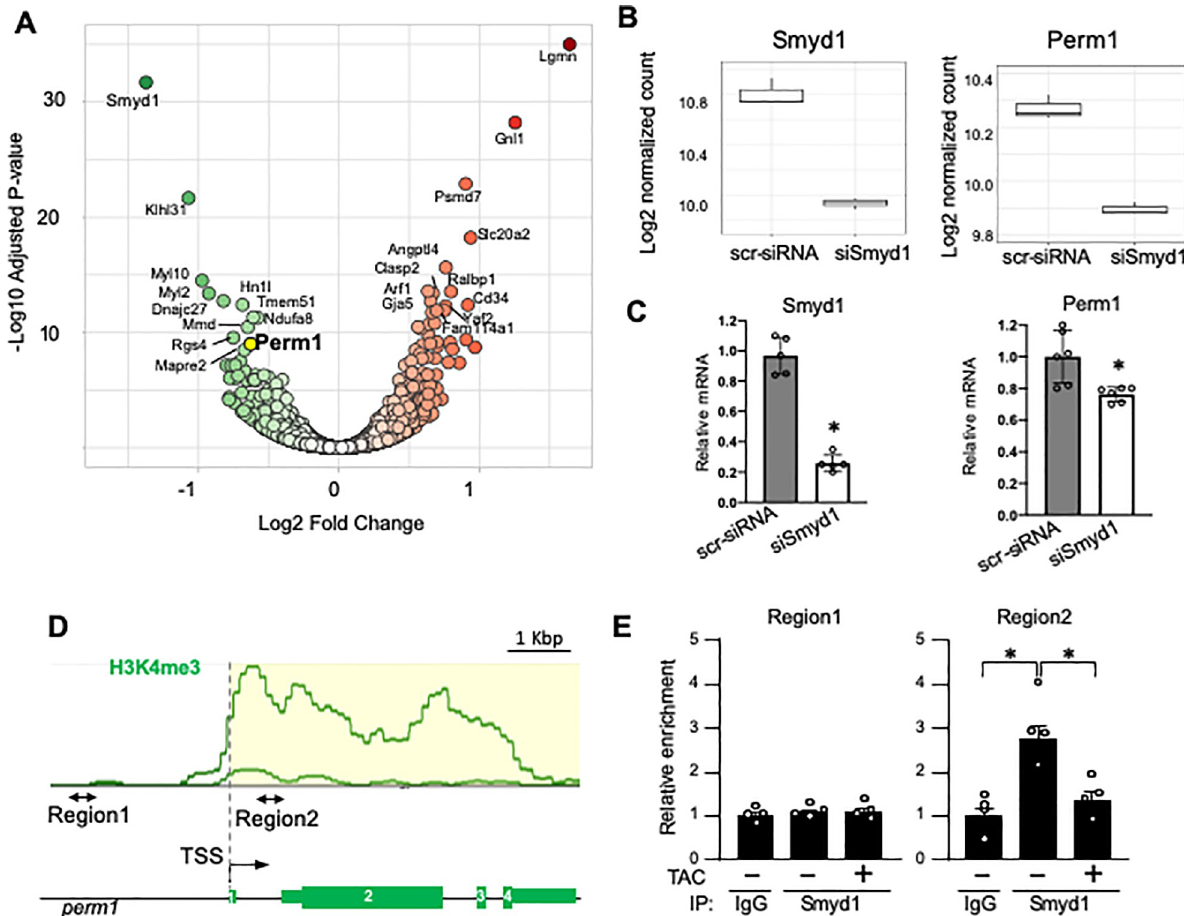
Fig 1. Perm1 is a downstream target of Smyd1. (A-B) RNA-seq of siSmyd1 cardiomyocytes. A volcano plot shows significantly downregulated (green) and upregulated (red) genes. Perm1, indicated by a yellow circle, is one of the genes most significantly downregulated by siSmyd1 (Panel A). Box plots show the decreased mRNA levels of Perm1 in cardiomyocytes in which Smyd1 expression was significantly reduced by siSmyd1 as compared with control cells that were treated with scrambled-siRNA (scr-siRNA) (n = 4/group, Panel B). ( C) qRT-PCR showing a significant reduction in Perm1 in cardiomyocytes in which Smyd1 was knocked-down by siRNA (n = 6/group). Statistics were performed using the t-test with 2 tails. � p < 0.05. ( D) Previous ChIP-seq studies have established enrichment of H3K4me3 within the promoter region of the Perm1 locus (WashU EpiGenome Database), which was targeted for qPCR reaction (“Region 2”). As a negative control, the ~2k bp upstream of the transcription start site (TSS) was targeted (“Region 1”), where small H3K4me3 peaks were observed. ( E) ChIP-PCR showing no significant interaction of Smyd1 with Region 1 ( left ), while Smyd1 does bind to Region 2 in the hearts of WT mice. This interaction was significantly reduced in the TAC heart (TAC +) ( right ) (n = 4 in sham, n = 4 in TAC). Statistics were performed using the t-test with 2 tails. � : p < 0.05. Error bars are ±